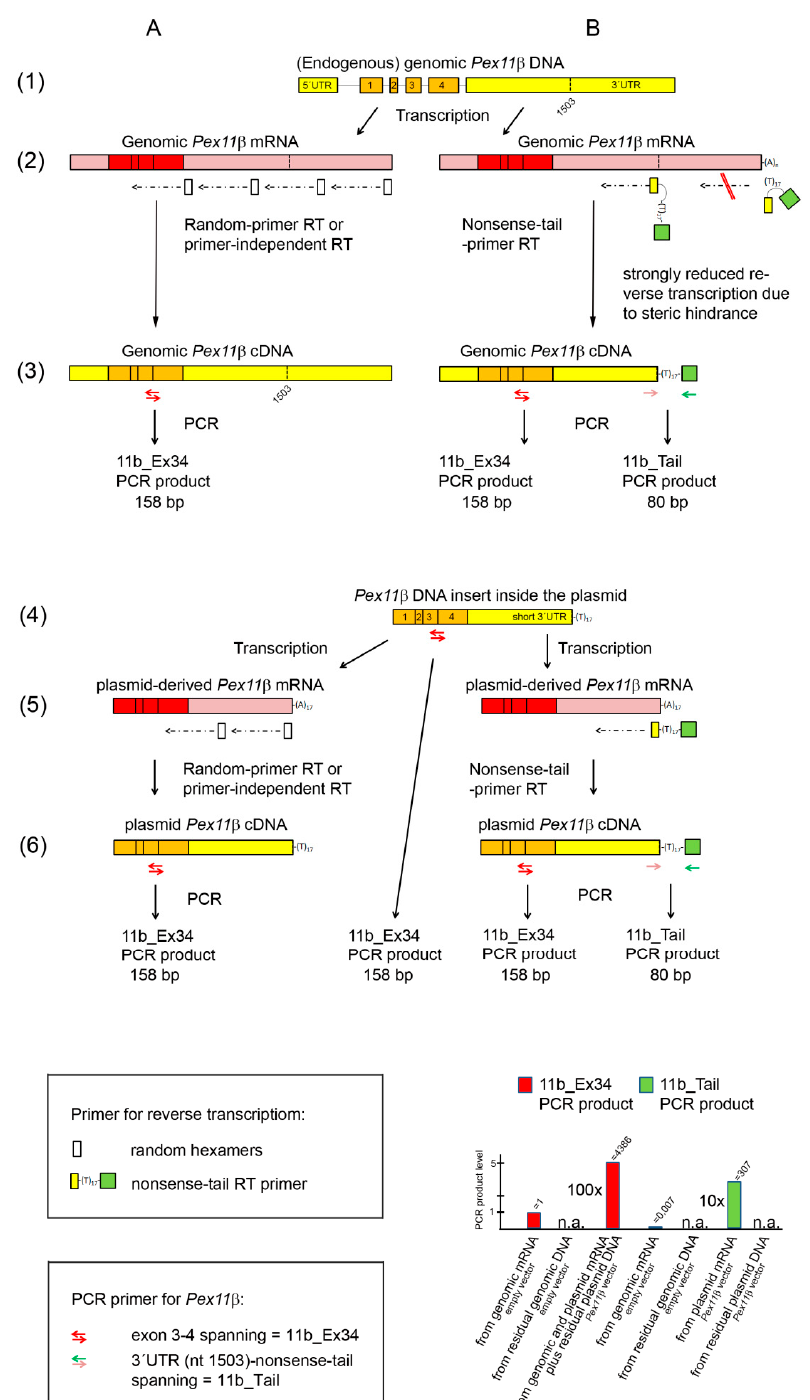
Figure 1. Schematic drawing of the mouse Pex11 β gene (genomic DNA, line 1) and the Pex11 β cDNA inserted into the expression vector (plasmid DNA, line 4), together with the corresponding transcripts (genomic mRNA in line 2, plasmid-derived mRNA in line 5) and di ff erent DNA copies (lines 3, 6) after reverse transcription using random hexamers ( A ) and the nonsense-tail RT primer ( B ), as well as in the absence of an RT primer (no RT primer RT, A). Symbols for the RT primer and PCR primer are shown in the top and lower box on the right, respectively. Localizations of the three Pex11 β PCR primer pairs (11b_Ex34, 11b_Tail) are shown. The histogram gives an overview of the relative PCR product levels obtained from genome- and plasmid-derived DNA and mRNA after random and nonsense-tail primer RT using the 11b_Ex34 (red) and 11b_Tail PCR primer (green).